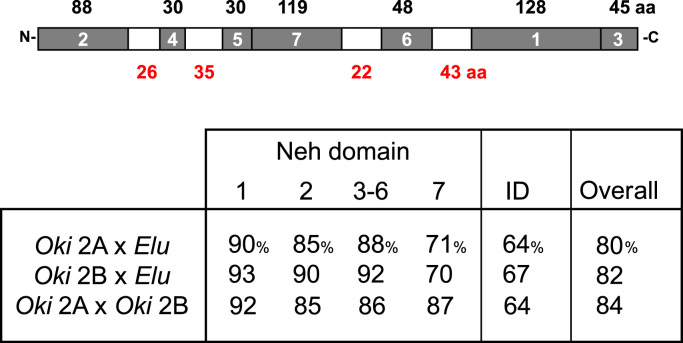
Shared identity between the Nrf2 paralogs of coho and northern pike indicates divergence within Neh7 domain. Coho paralogs (Oki) and the pike (Elu) ortholog share similarly high identities (85–92%) in canonical Neh domains 1–6 and similarly lower identities in interdomain (ID) regions (64–67%). High identity is maintained between the coho forms within Neh7 while diverging from the pike ortholog. The schematic represents Oki Nrf2A with Neh regions numbered and amino acid count of domains and ID regions indicated above and below, respectively.